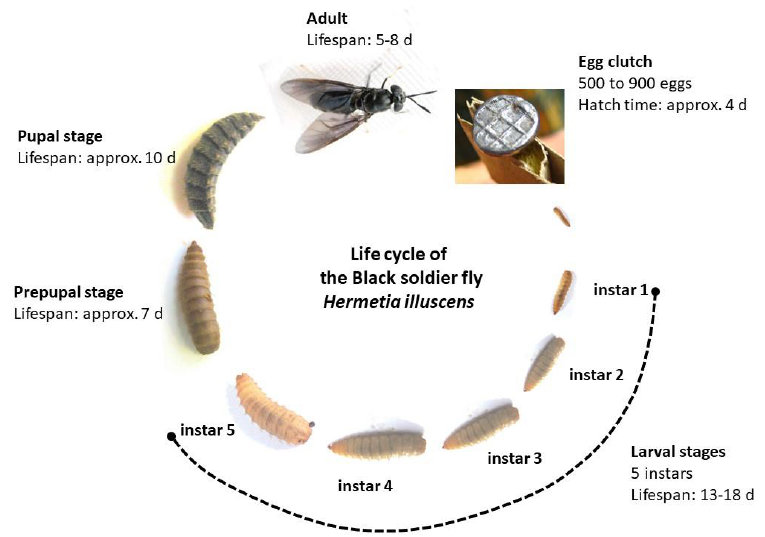
Figure 1. Life cycle of the Black soldier fly Hermetia illuscens , comprising the egg stage, five larval stages (instar 1 – 5), the prepupal stage, the pupal stage and the imago, modified from de Smets et al. [79] and Lievens et al. [80].